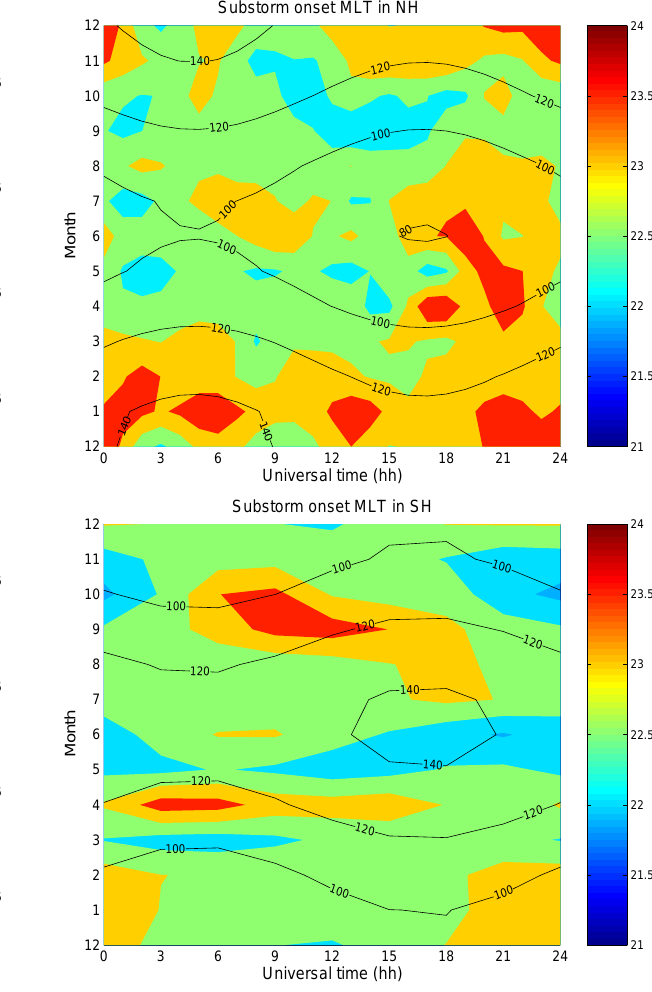
Fig. 7. Same as Fig. 6, but for onset local time. ing average latitude (valid for E m = 0) is about 73 ◦ MLat for the Northern Hemisphere and about 72 ◦ for the south. This small difference cannot be considered as significant. We have compared the monthly mean latitudes, after applying the cor- rection, with the monthly mean values of SZA and found no correlation in any of the hemispheres. When looking at Fig. 8 some systematic latitude struc- ture seem to remain, however, after the removal of the de- pendence on magnetic activity. Obviously, substorms oc- cur about 2 ◦ more equatorward during equinoxes than dur- ing solstice. This implies a systematically larger polar cap area during equinoxes, which may be consistent with the Russell-McPheron and McIntosh effects. Liou et al. (2001) also found that the average onset latitude is lowest in spring, then followed by summer and winter. Wang et al. (2005b) have reported average onset latitudes 1.5 ◦ more poleward for events in sunlight compared to those in darkness. From